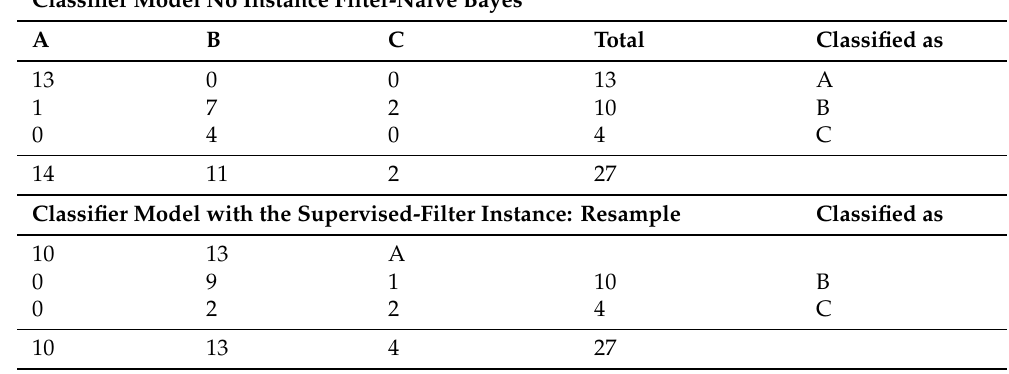
Table 7. Confusion matrix of the classification of the level of energy-environmental e ffi ciency with naive